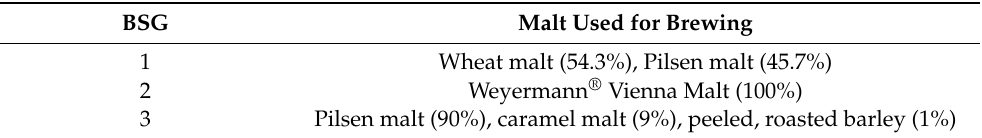
Table 1. Brewer ´ s spent grain (BSG) samples and malt used for